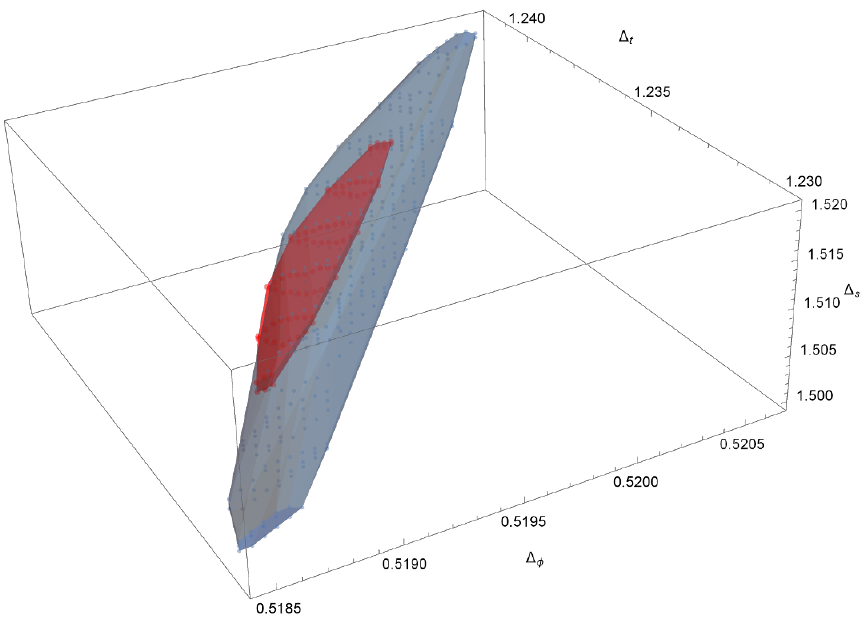
Figure 2 . Three-dimensional plot of the O(2) island. The blue region is the one obtained in appendix B of [35], and the red region is our